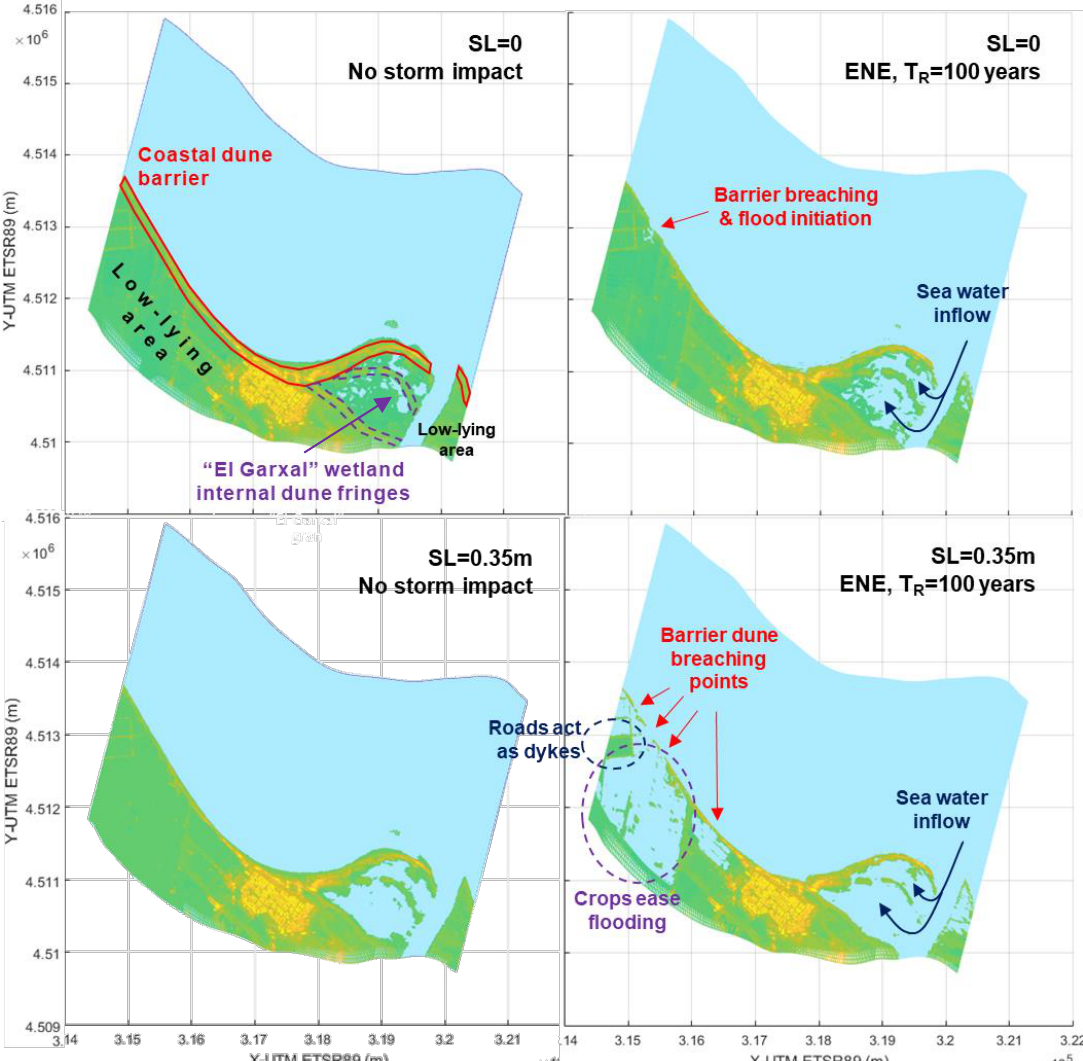
Figure 5. Flood map before (left panels) and after (right panels) the impact of an ENE storm with a return period of 100 years. Left panels can be considered as the effect of static sea level (i.e., bath-tub approach). Top panels correspond to scenario 1 (present climate without storm surge, SL = 0 m), while bottom panels are associated to scenario 2 (present climate with storm surge, SL = 0.35 m). Green areas represent emerged elevation below 1 m; whereas yellow areas are above 1 m.